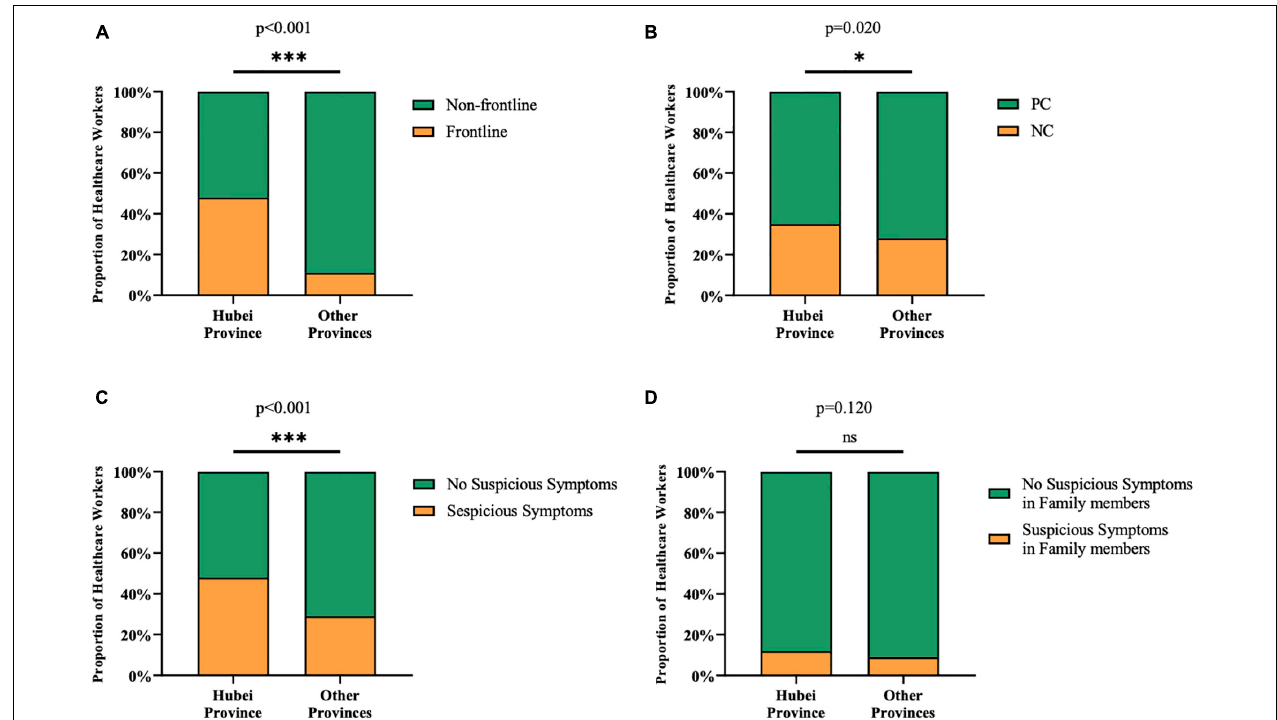
FIGURE 2 | Difference in potential risk factors on ADSs between Hubei province and other provinces. (A) More healthcare workers worked on the frontline in Hubei province (48%) than those in other provinces (11%). (B) The proportion of participants with negative coping style was slightly larger in Hubei (35%) than that of other provinces (28%). (C) Healthcare workers in Hubei province (48%) were more frequent to have suspicious symptoms compared with other provinces (29%). (D) There was no significant difference in the proportion of healthcare workers who had family members with suspicious symptoms between Hubei (12%) and other